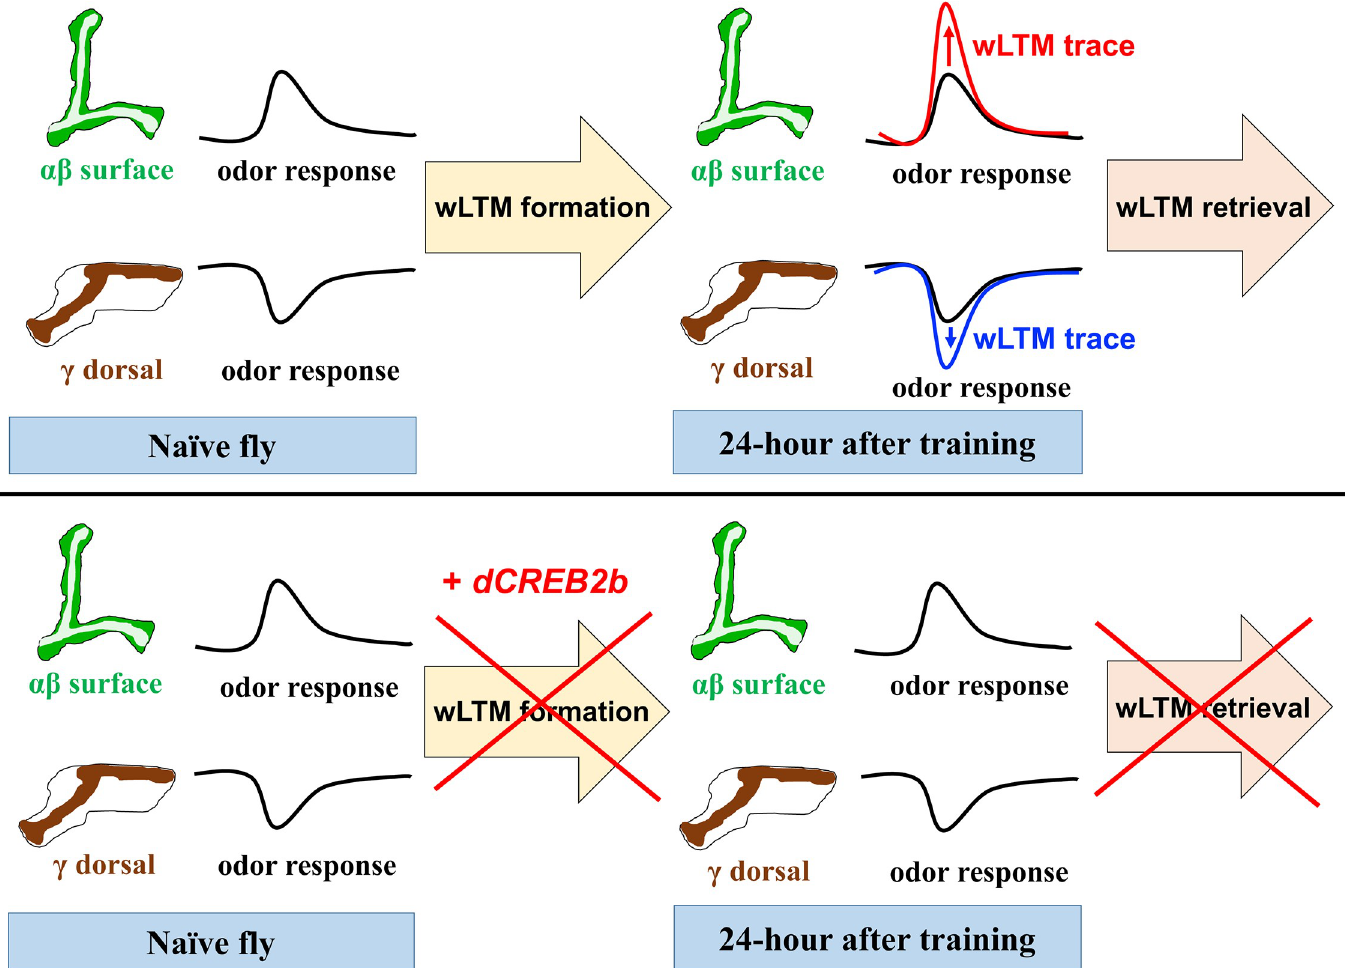
Fig 8. A brain circuitry model of CREB2 and wLTM. The αβ surface neurons show an evoked calcium response to odors while the γ dorsal neurons show a decreased calcium response to odors in na ï ve flies. After odor/water association which induces the formation of wLTM, calcium response to training odor was further increased in αβ surface neurons, whereas the calcium response was further decreased in the γ dorsal neurons 24-hour after training. These increased and decreased cellular calcium responses to training odor in αβ surface and γ dorsal neurons, respectively, were abolished by dCREB2b expression, suggesting that training-induced cellular calcium responsive changes in distinct MB subsets form wLTM traces with different neuronal dynamics in thirsty